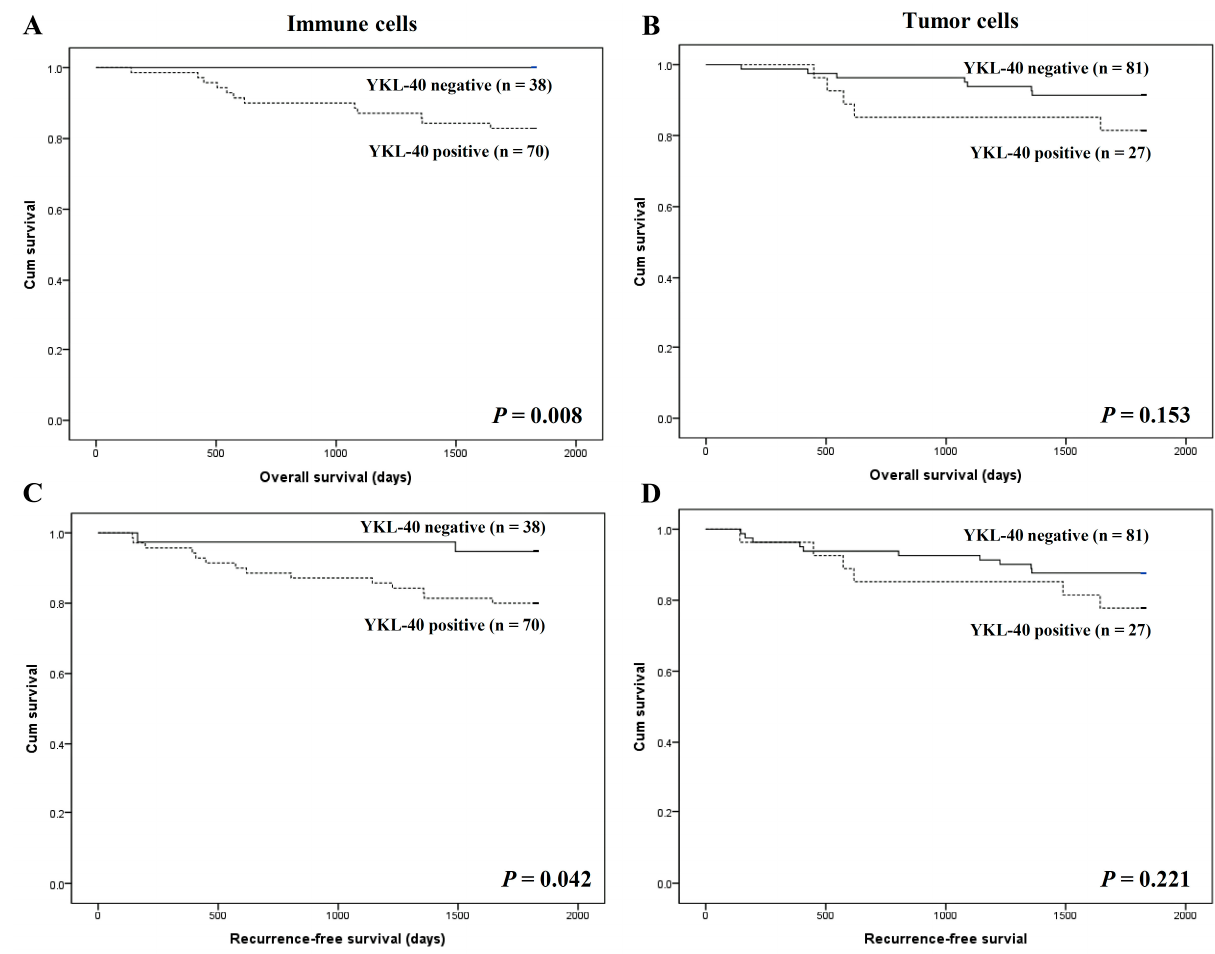
Figure 3. Kaplan–Meier analysis of patient survival according to YKL-40 expression in colorectal cancer cells of patients with high immunoscores. ( A ) Overall survival according to YKL-40 expression in immune cells. ( B ) Overall survival according to YKL-40 expression in tumor cells. ( C ) Recurrence-free survival according to YKL-40 expression in immune cells. ( D ) Recurrence-free survival according to YKL-40 expression in tumor cells.